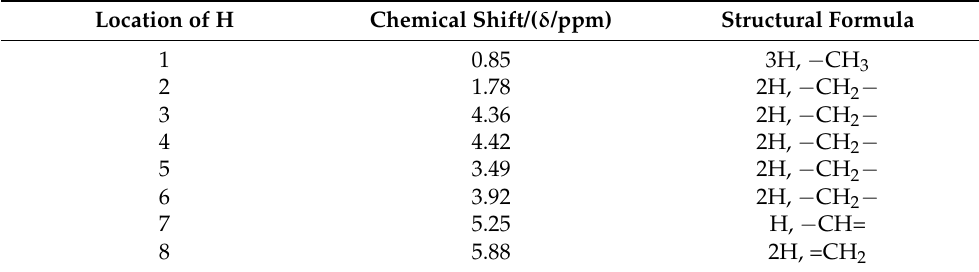
Table 2. Analytical table of the 1 H-NMR spectrum for the 3-ethyl-3-allylmethoxyoxetane.